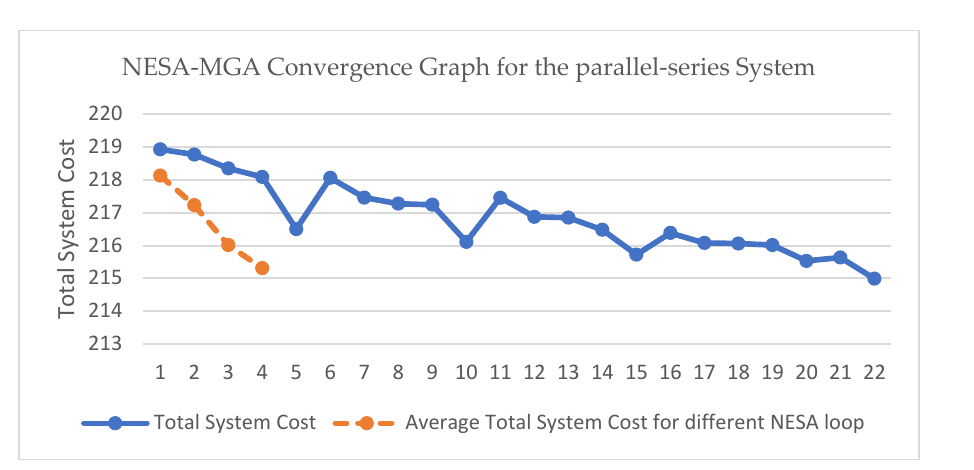
Figure 11. The convergence graph of the parallel-series system by introducing the NESA-MGA combined method.